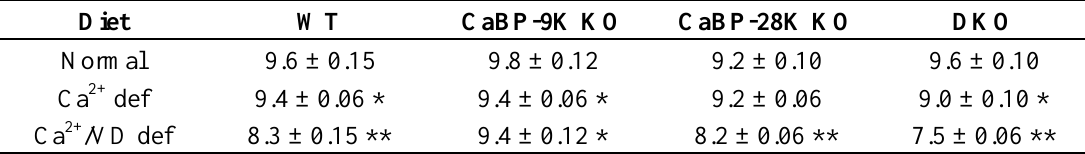
Table 1. Regulation of serum calcium concentrations (mg/dL) in CaBP knockout (KO) mice given a calcium-deficient or calcium/vitamin D-deficient diet. DKO, double KO.